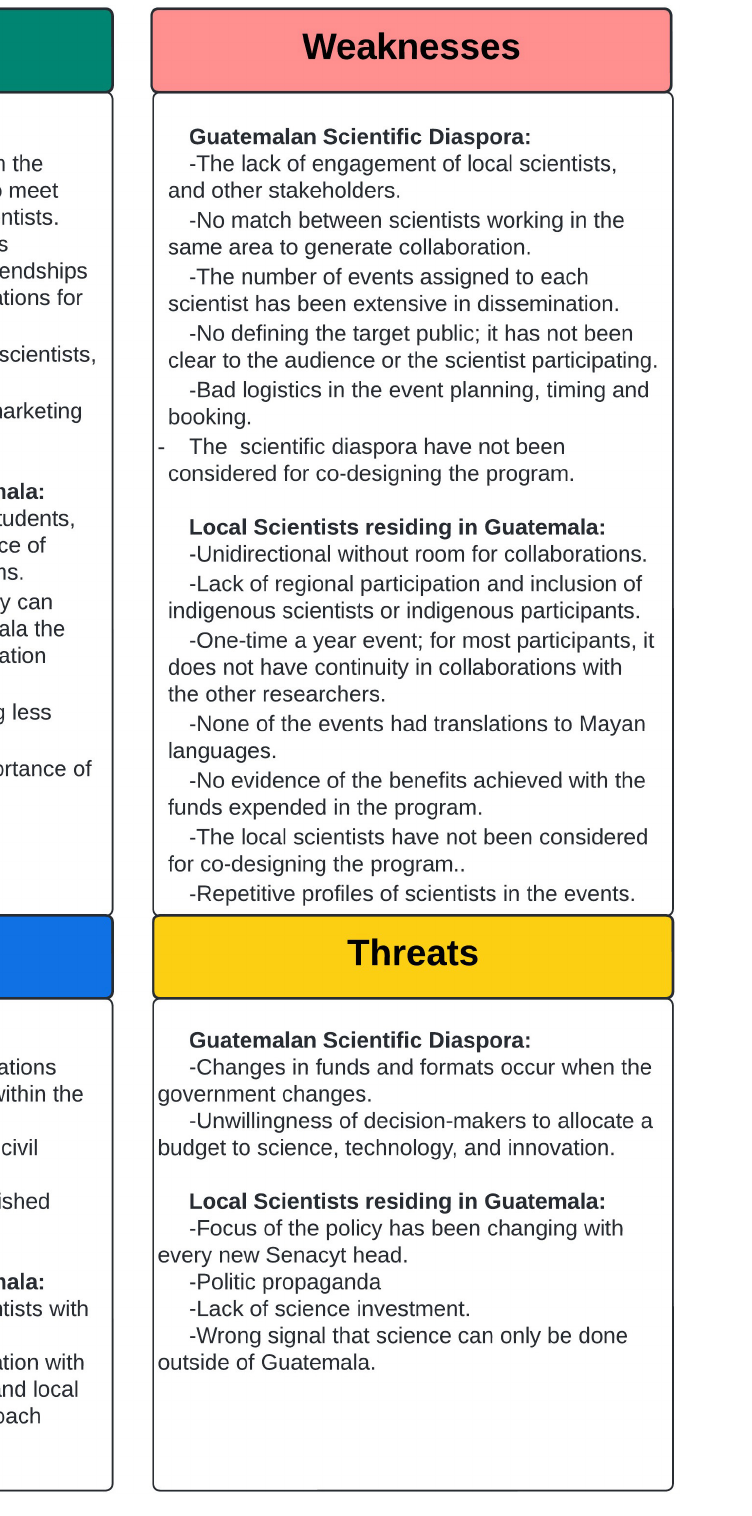
FIGURE 4 | Converciencia strengths, weaknesses, opportunities, and threats ( SWOT) analysis. Source: Own elaboration.